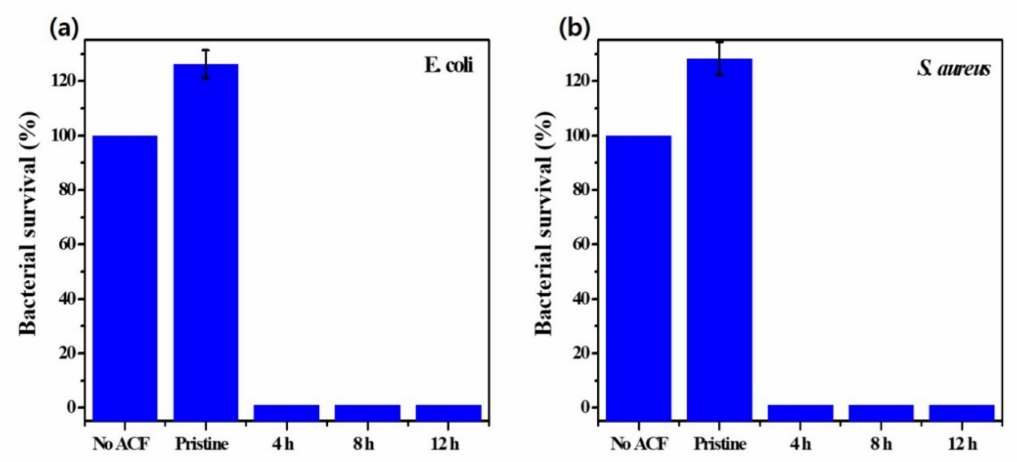
Figure 8. Antimicrobial e ff ects of the activated carbon fibers (ACF) and ACF@polydopamine-cupric oxide (PD-CuO) with di ff erent coating time against ( a ) E. coli and ( b ) S.